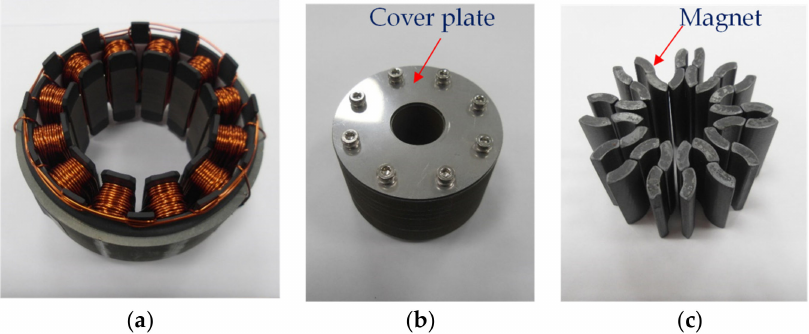
Figure 17. Prototype of the proposed model; ( a ) stator assembly; ( b ) rotor assembly; ( c ) magnet arrangement for flared shape.